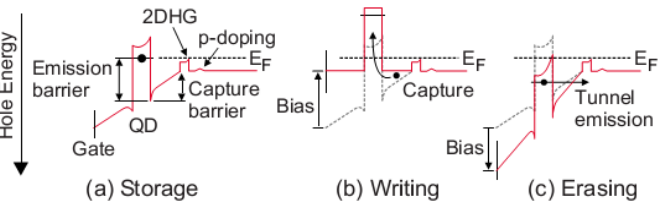
Figure 2. Schematic illustration of the ( a ) storage, ( b ) write and ( c ) erase operations in the SAQD–Flash concept